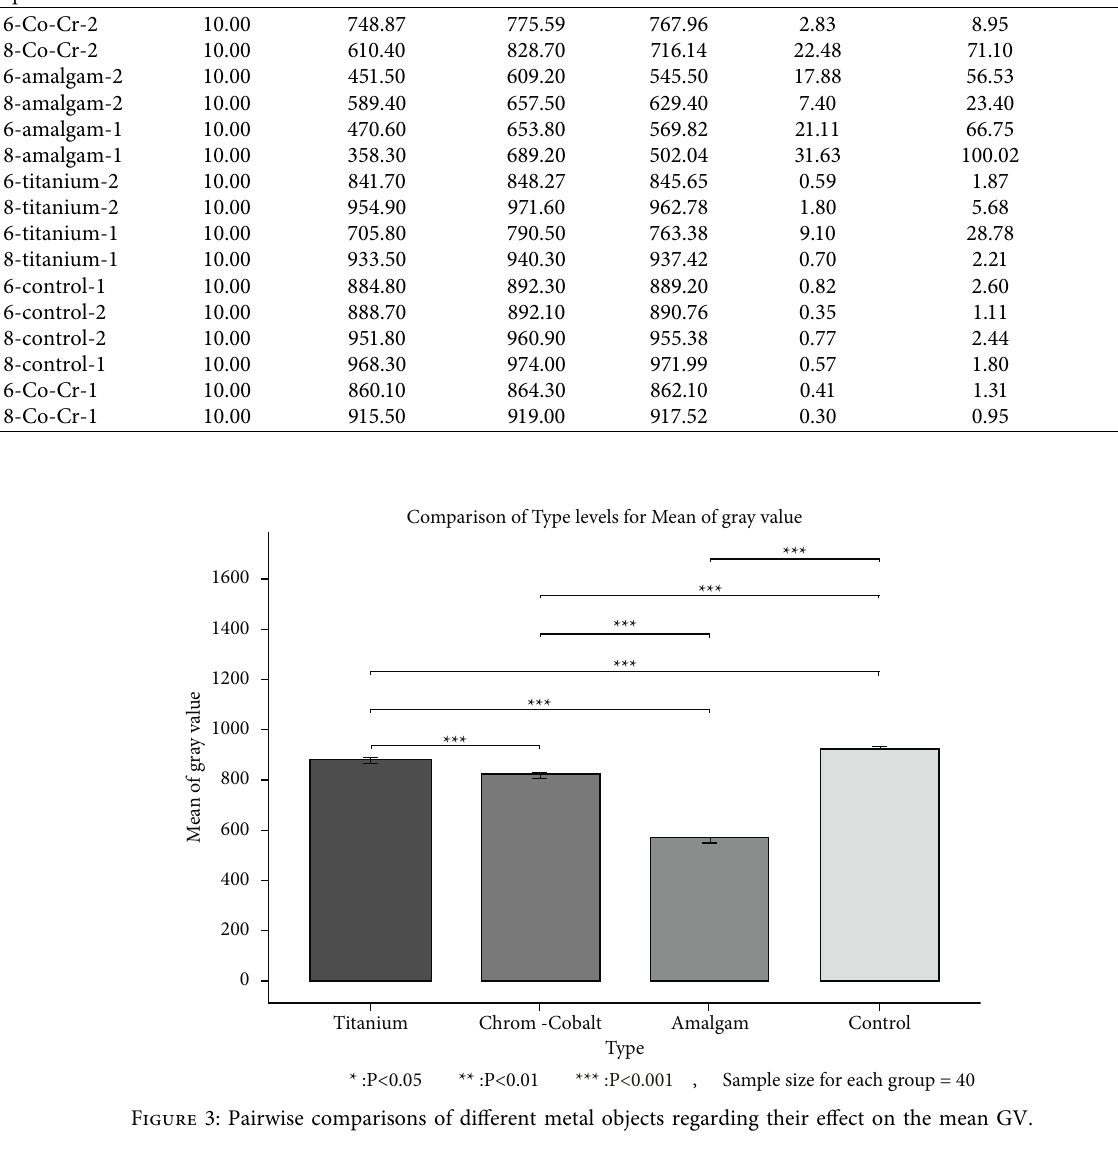
Table 1: Descriptive findings regarding the mean GV based on the size of FOV and the type and number of metal objects ( n � 10). Group